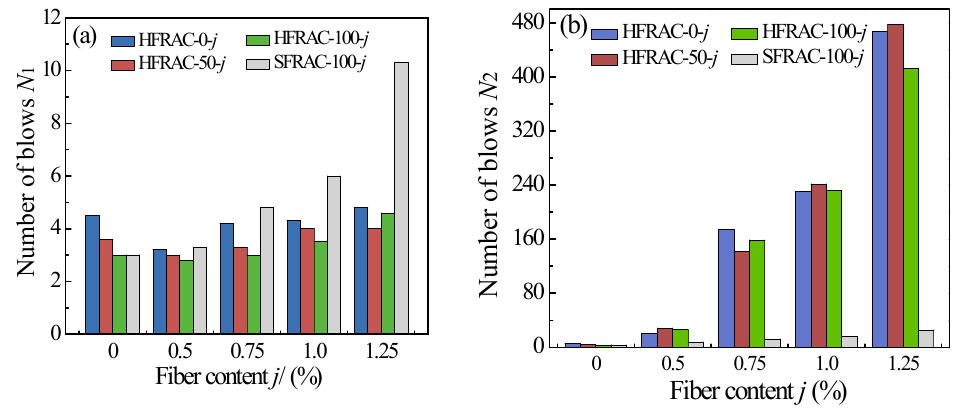
Figure 3. Test results of impact resistance: ( a ) number of blows for first crack N 1 ; ( b ) number of blows for ultimate crack N 2 .